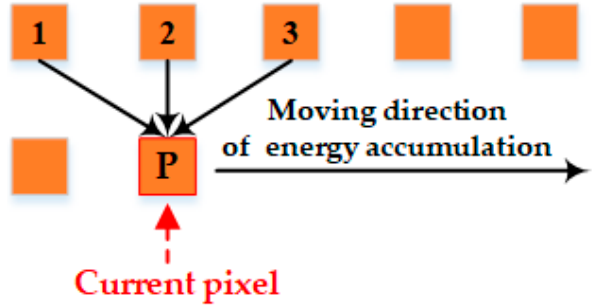
Figure 1. The schematic diagram of Duplaquet’s energy criterion.